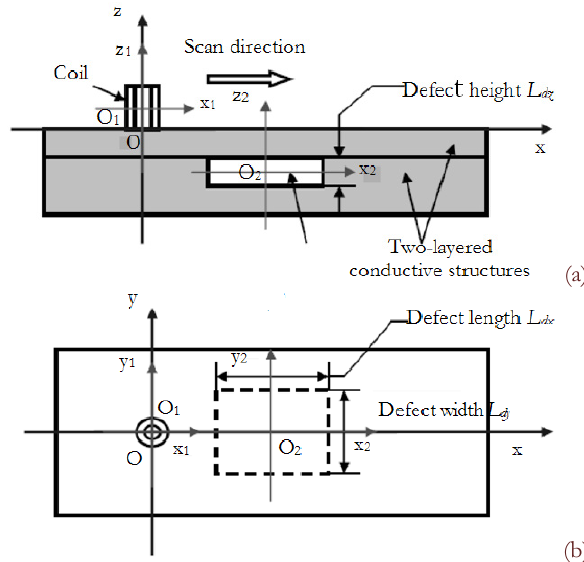
Figure 1: Schematic diagram of the detection system. (a) Sectional view; (b) Top